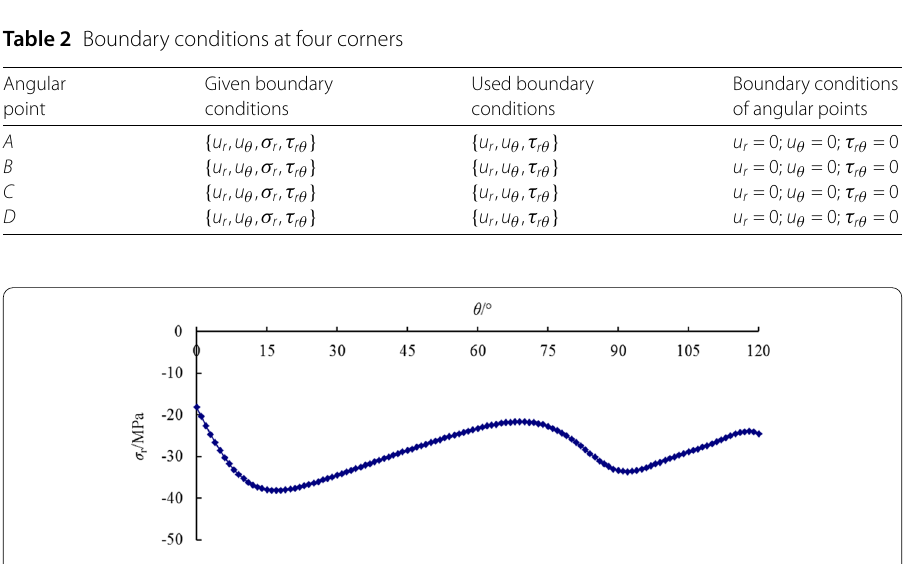
Figure 3 Distribution of radial stress along the middle